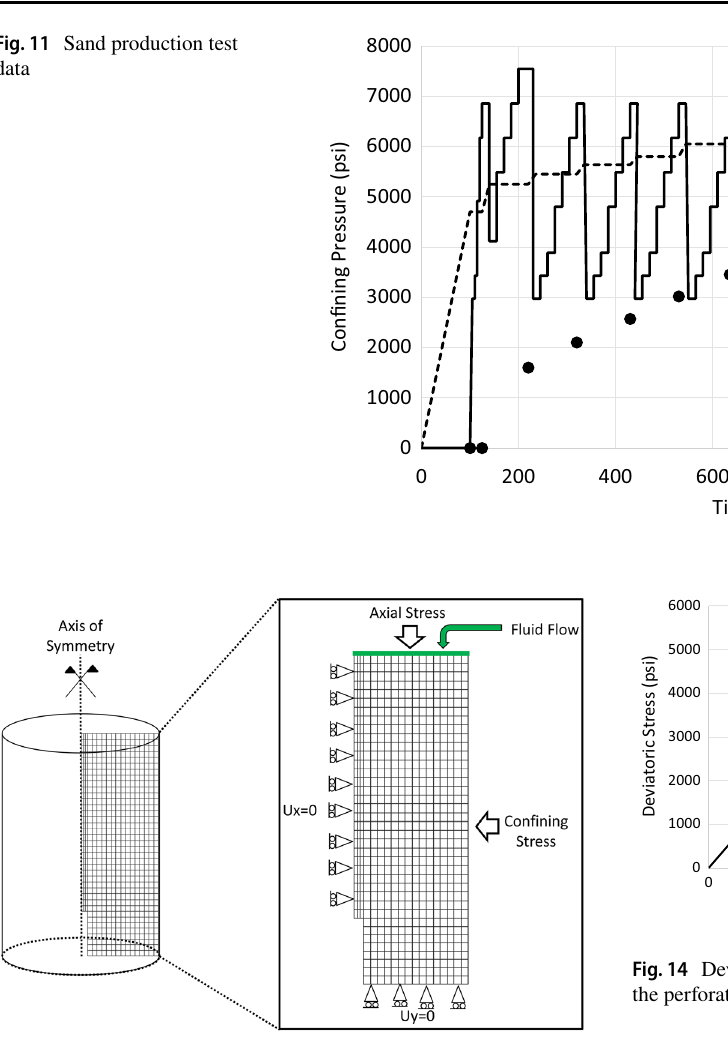
Fig. 12 Geometric domain and boundary conditions of numerical model